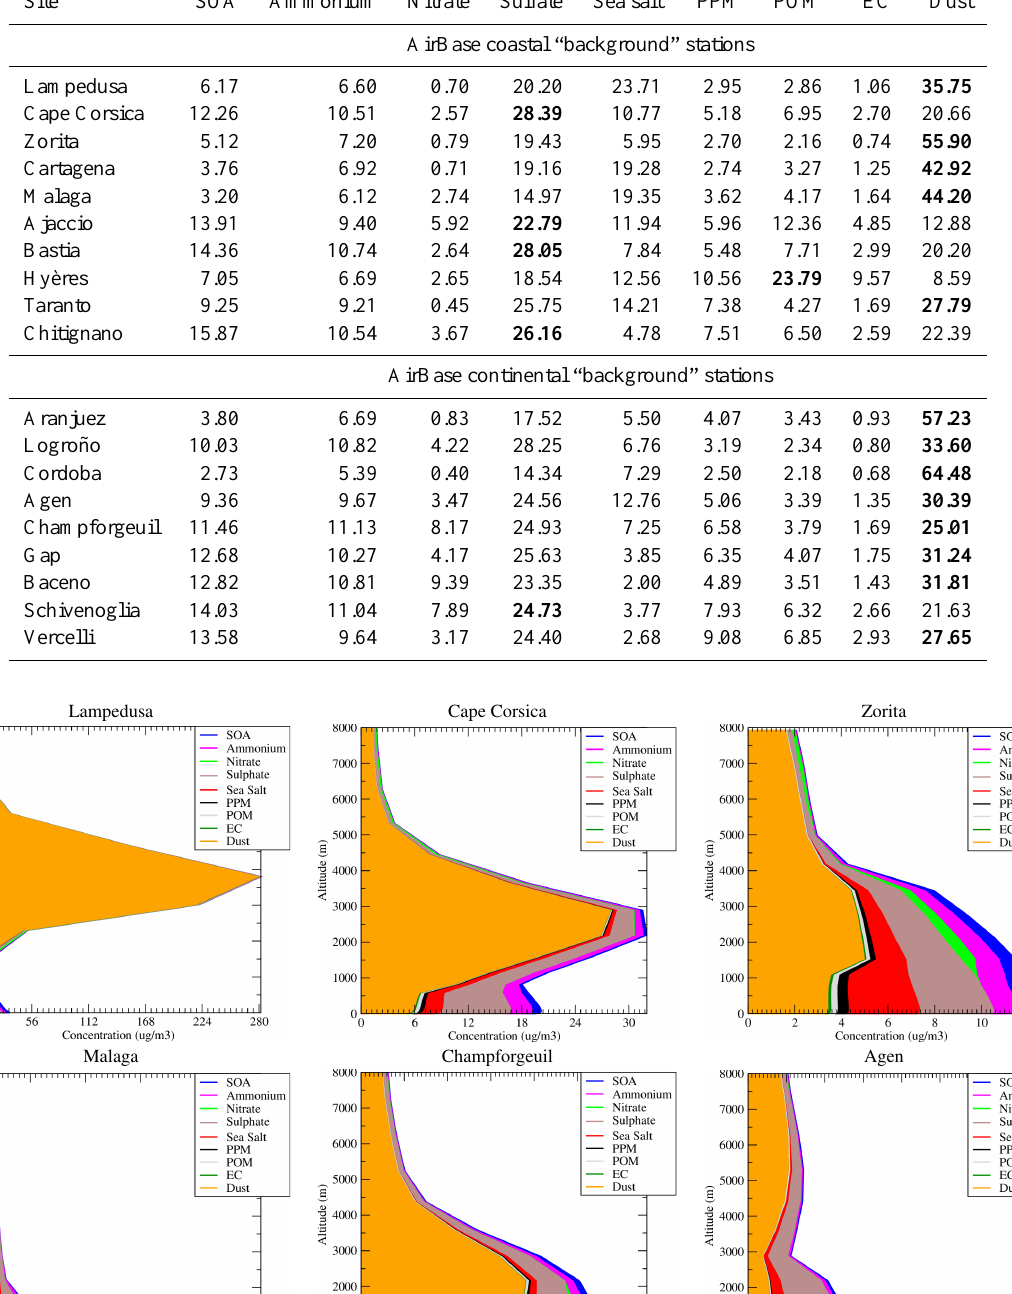
Table 10. Relative percentages of the chemical composition of the modeled surface PM 10 for each site. Values are calculated using the hourly values for the period from 1 June to 15 July 2013. For each site, the largest value is written in bold. Site